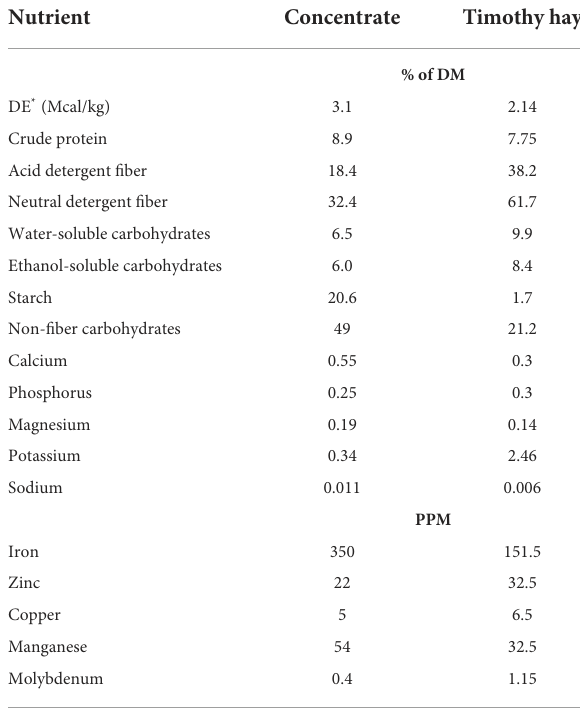
TABLE 2 Nutrient composition of the daily ration on dry matter